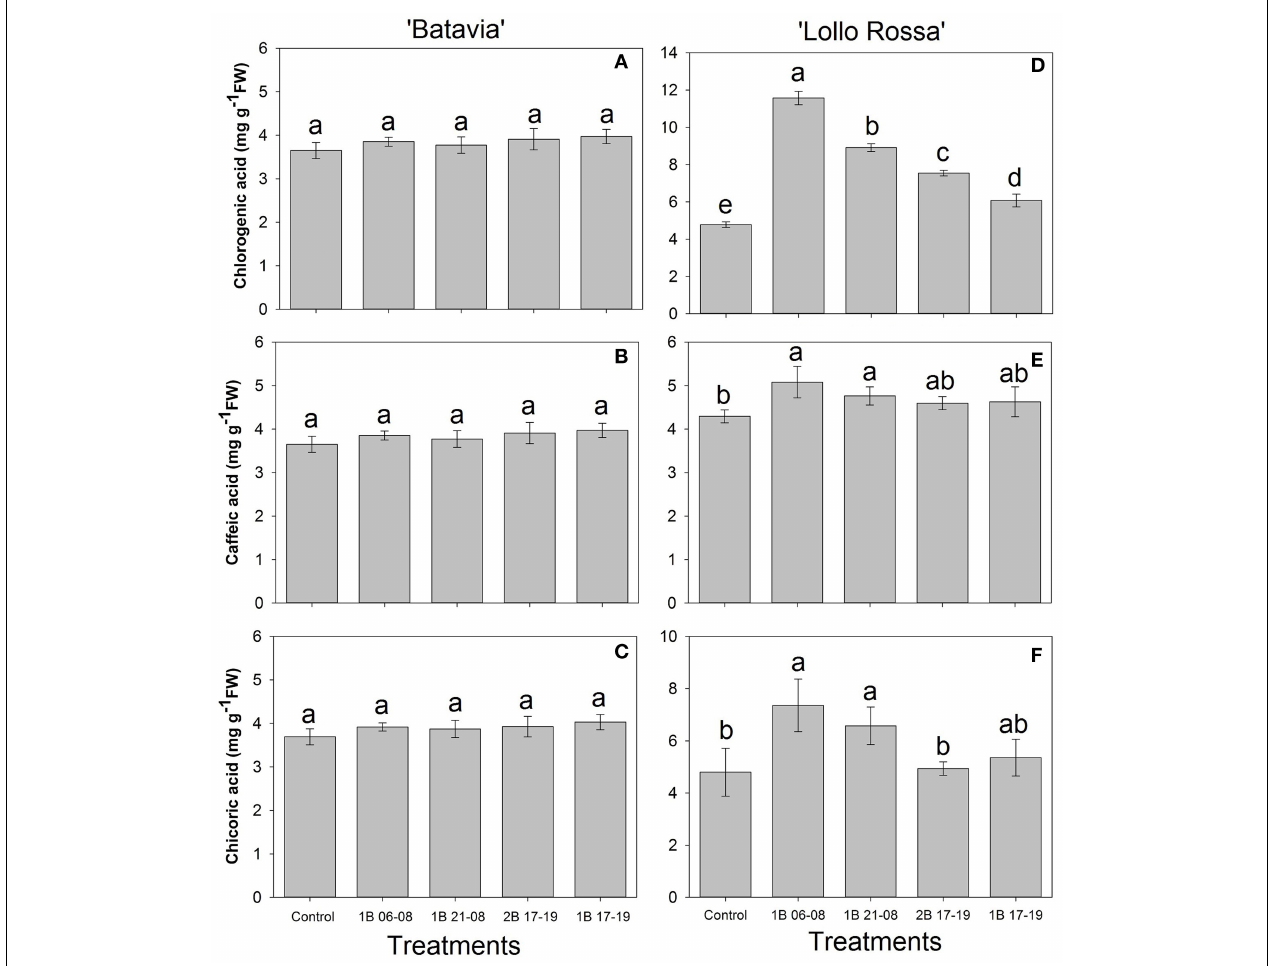
FIGURE 7 | Phenolic acid (chlorogenic acid, caffeic acid, and chicoric acid) of Lactuca sativa “Batavia” (A–C) and “Lollo Rossa” (D–F) grown under the five different LED treatments with the same abbreviations as in Figure 2. Data are mean values